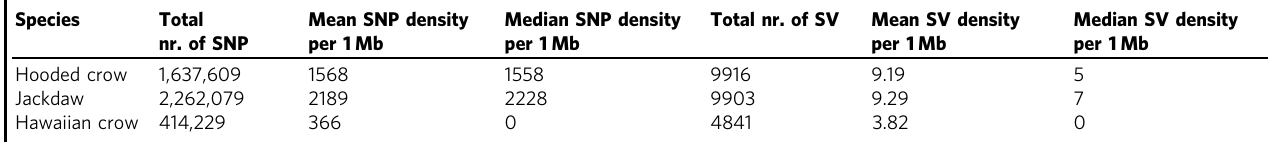
Table 1 Assembly-based structural variation and single-nucleotide polymorphism detection.